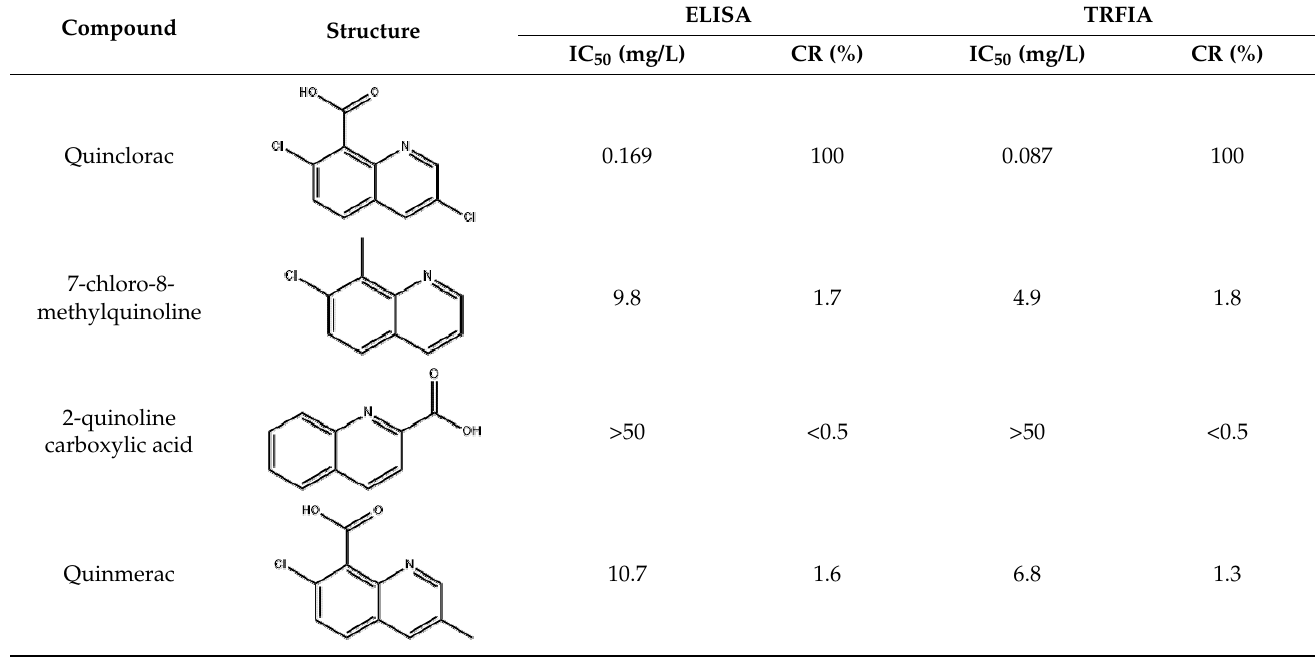
Table 1. The cross-reactivity of analogs related to quinclorac by ELISA and TRFIA. Compound